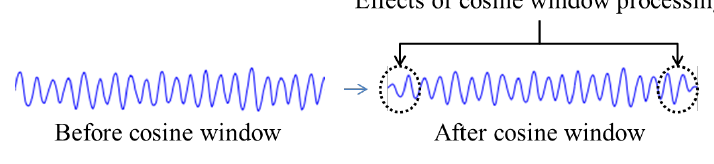
Figure 4. Effects of cosine window process in TCSC.